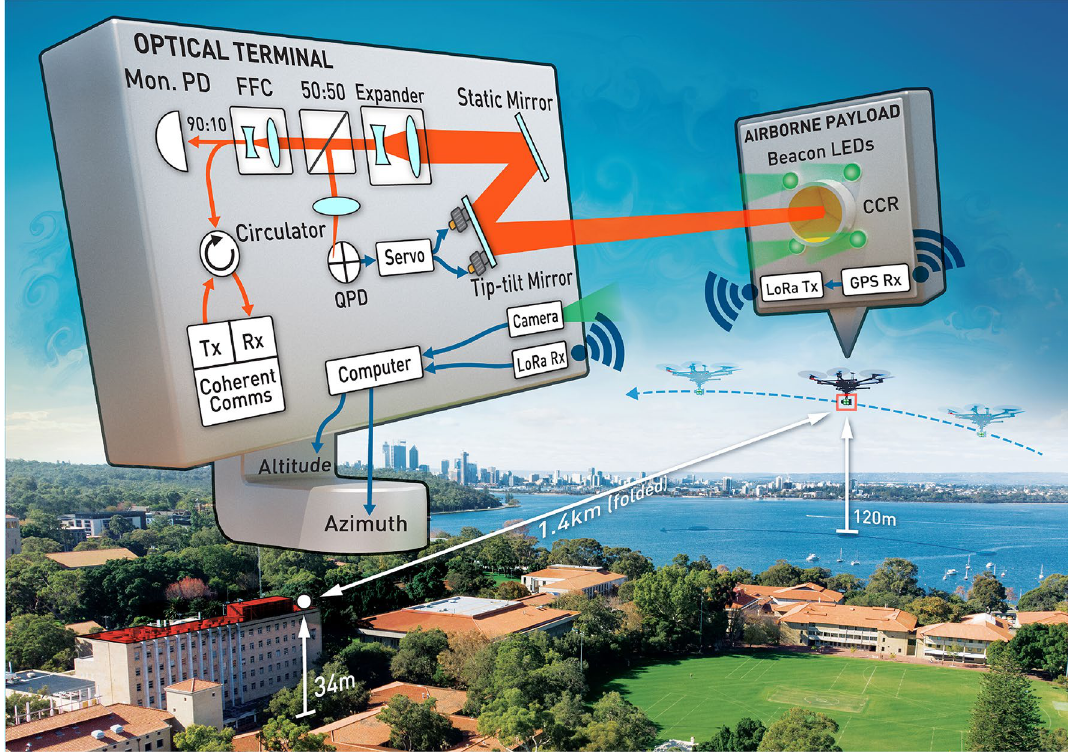
Figure 1. Schematic of the deployable optical terminal and experiment. Mon. PD monitoring photodetector, FFC fiber to free-space collimator, QPD quadrant photodetector, CCR corner-cube retroreflector, LED light emitting diode, LoRa “Long Range”, Tx transmitter, Rx receiver.